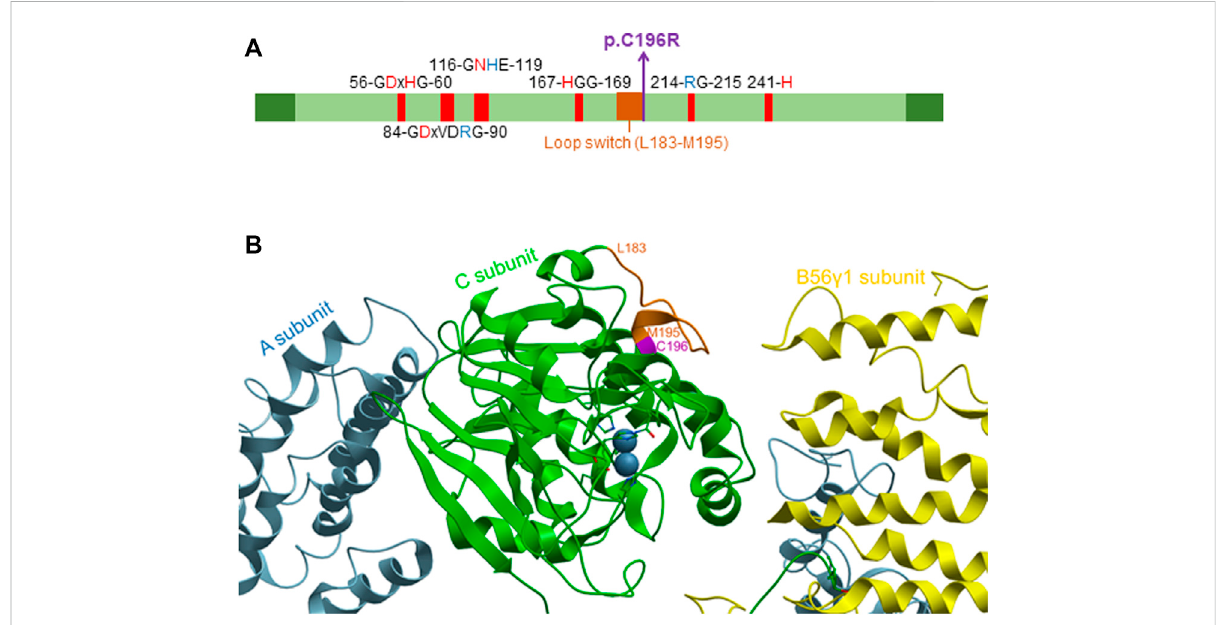
FIGURE 3 Localization of the p.Cys196Arg variant in the catalytic PP2A C α subunit. (A) Domain organization of the catalytic PP2A C α subunit. The p.Cys196Arg variant in PP2A C α is indicated in purple (bold), and other conserved residues in the catalytic subunit are also shown. Red amino acids denotemetalbinding,whileblueaminoacidsdenotephosphatebinding.Theloop switchisindicatedinorange[ fi gureadaptedfromVaneyndeetal. (2022)]. (B) Structure of the catalytic PP2A C α subunit. The structure was generated based on PP2A-B56 γ 1 crystallographic data, using PDB code2IAE(ChoandXu,2007)andMolsoftMolBrowser3.9-2bsoftware(ICM-Browser-Pro).ThecatalyticC α subunitisshowningreen,theAsubunit insky-blue,andtheB56 γ